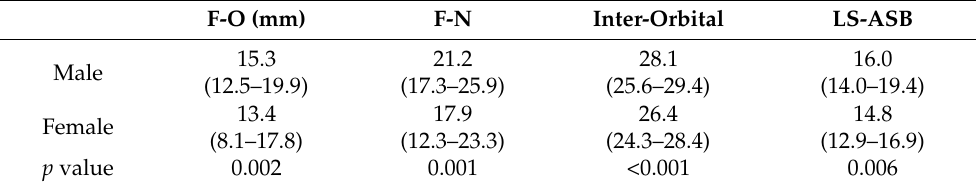
Table 3. The distances in Waters’ view and CT scan in different